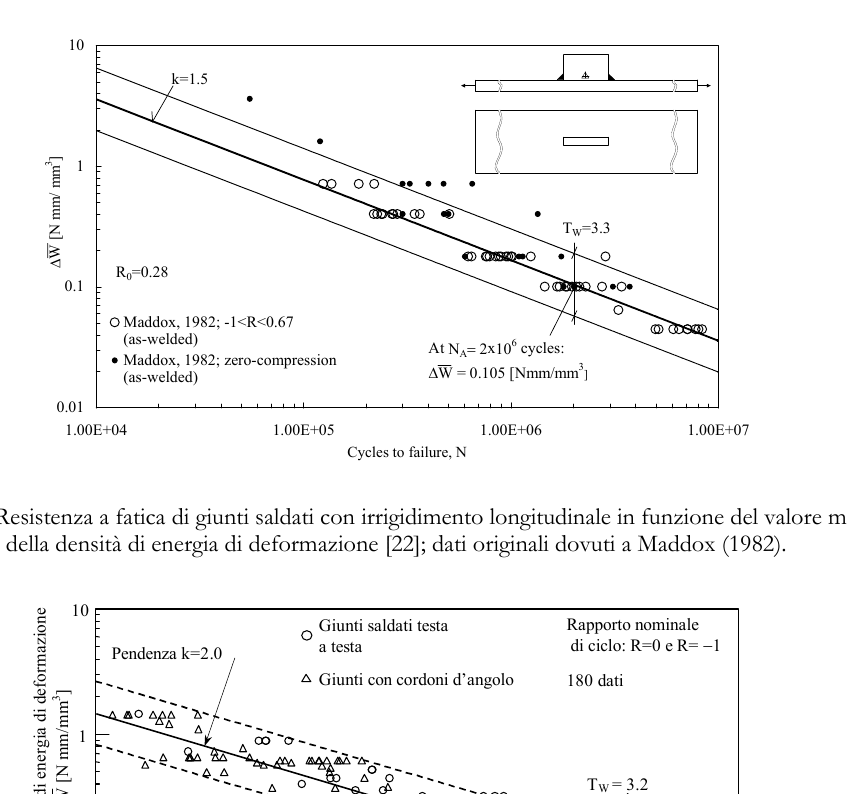
S INGOLARITÀ ‘ OUT - OF - PLANE ’ INDOTTE DA EFFETTI